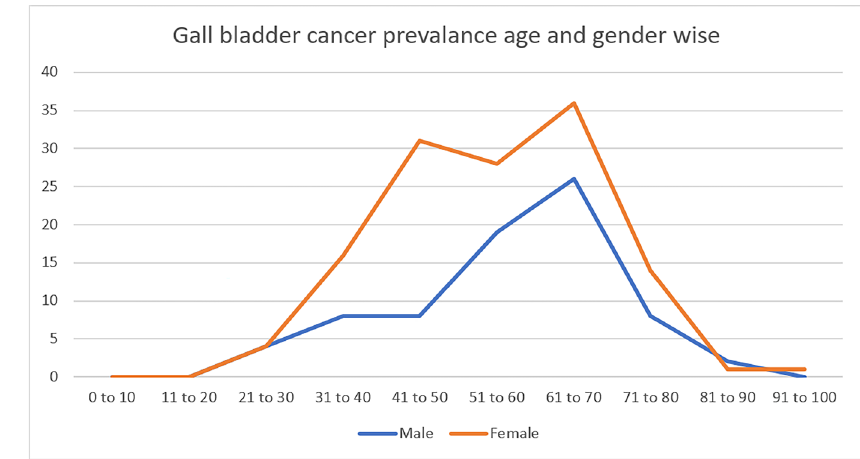
Figure 4. Prevalence of gall bladder diseases (as per age and